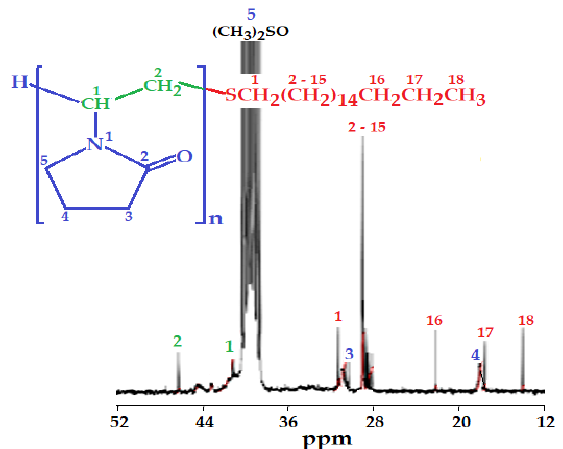
Figure 1. 13 C NMR spectra of the synthesized PVP-OD in DMSO-d6 showing the structure of the oligomers and peak assignment.